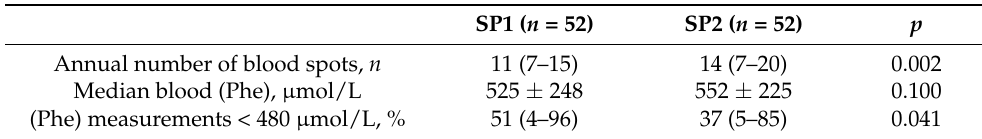
Table 2. Metabolic control of patients from the final sample ( n = 52). Results are expressed as median (P 25 –P 75 ) or mean ± SD. p < 0.05 was considered